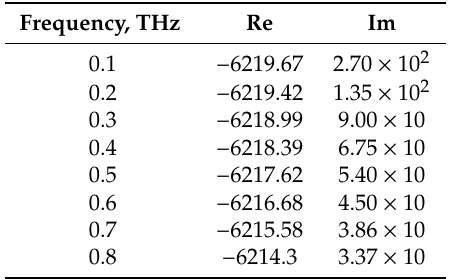
Table 2. Calculated relative permittivity of copper.